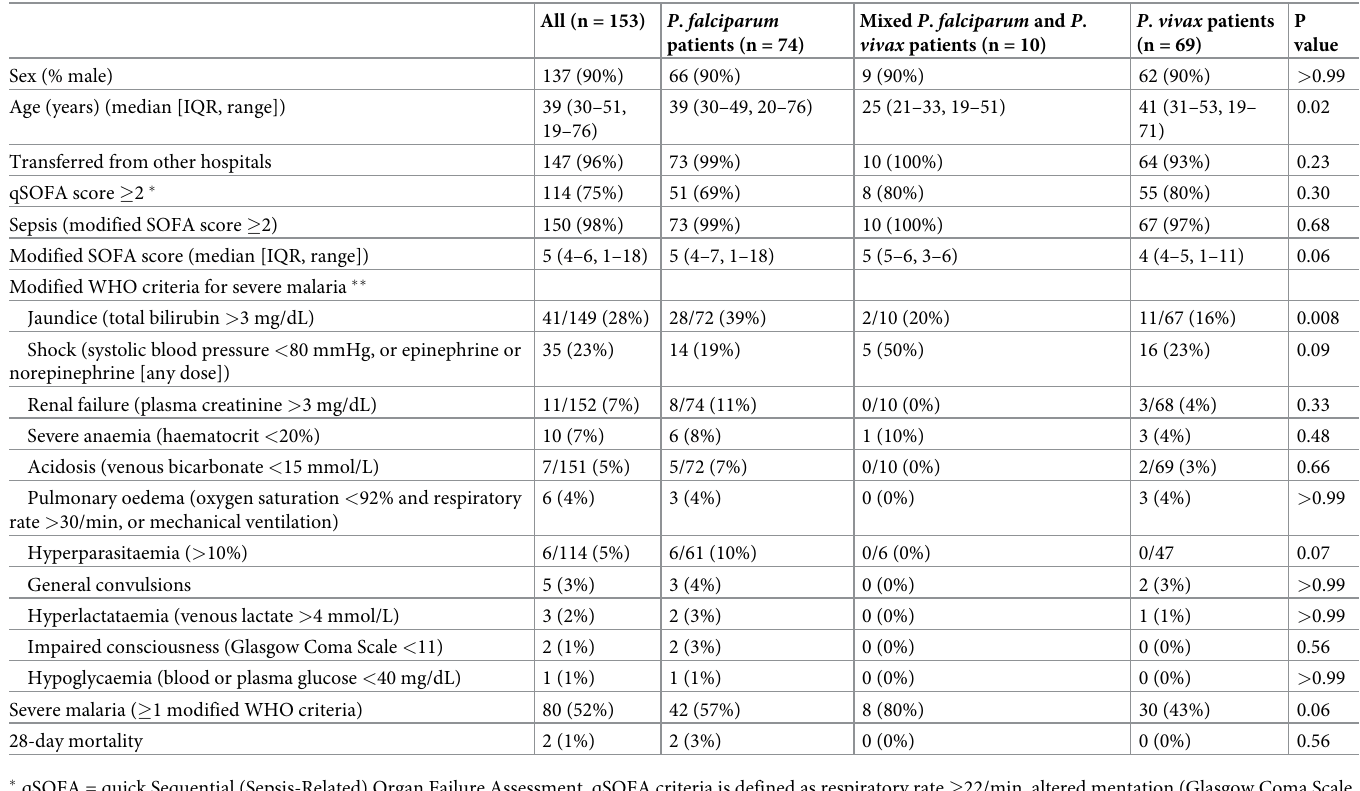
Table 2. Baseline characteristic of 153 malaria